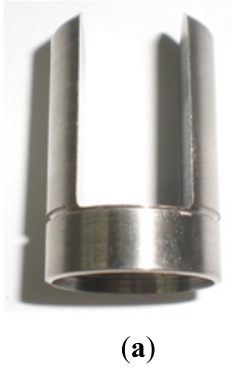
Figure 6. ( a ) Tuning fork; ( b ) Support